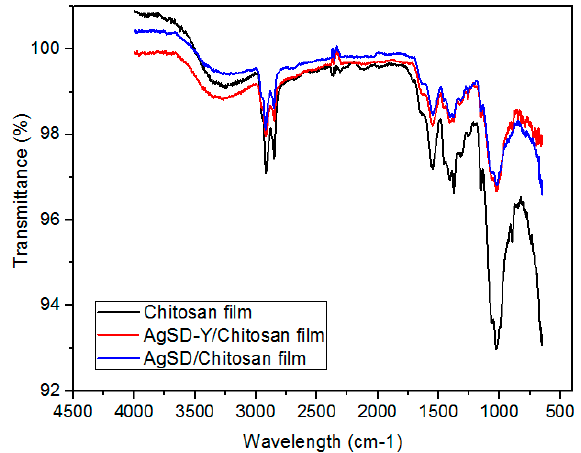
Figure 11. Infrared spectrum of the chitosan film, AgSD-Y/Chitosan film and AgSD/Chitosan film. Table 2. Vibrational bands obtained for Chitosan films, AgSD/Chitosan film and AgSD-Y/Chitosan film.